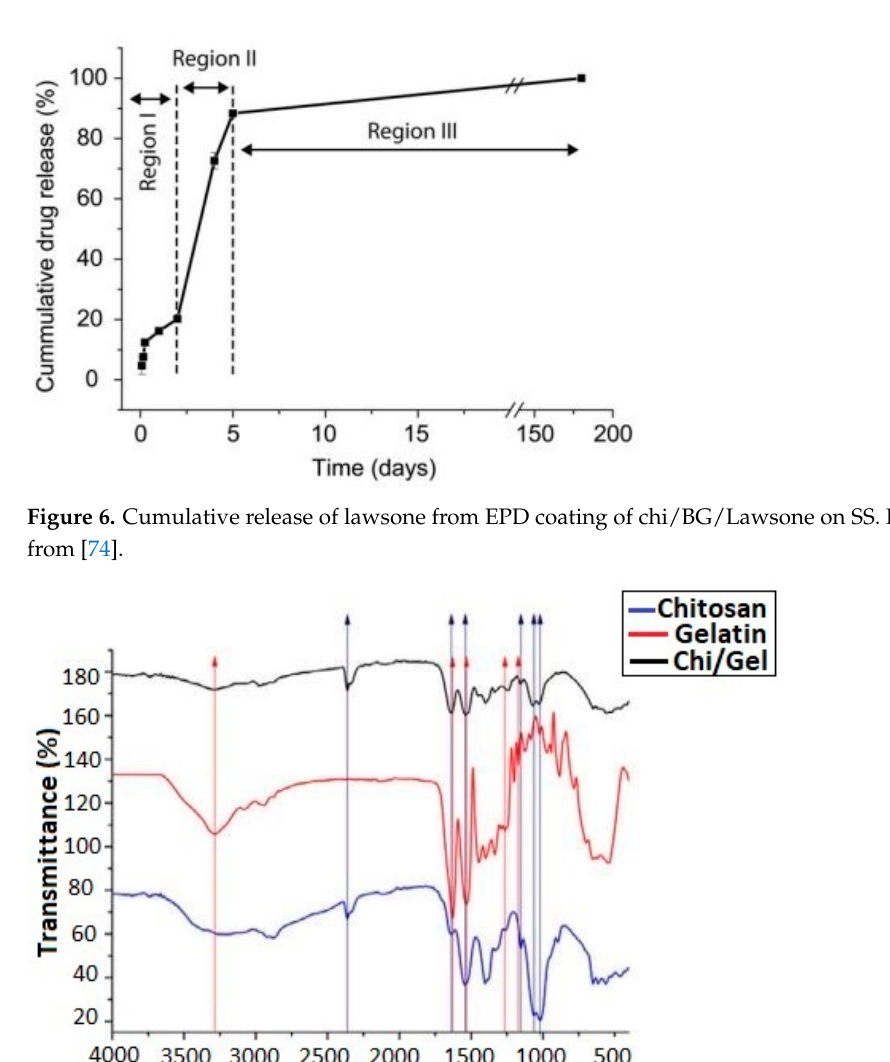
Figure 6. Cumulative release of lawsone from EPD coating of chi/BG/Lawsone on SS. Reproduced from [74].